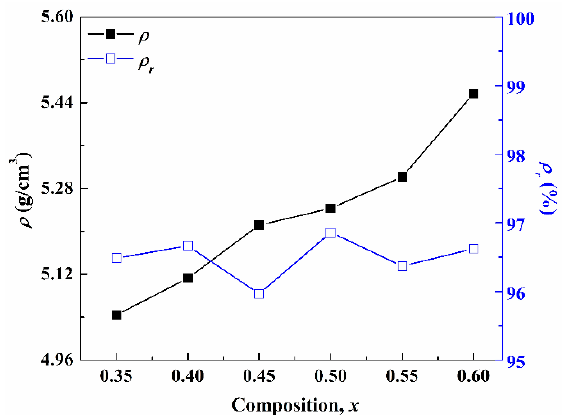
Figure 1. Bulk density of the (1– x )CLT- x NMT ceramics.